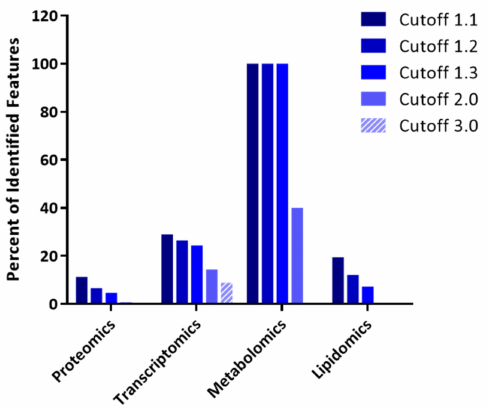
Figure 1. The impact of thresholding strategy on the integrative analysis of parallel multi-omics datasets. Bar graph representation of features remaining in each omics dataset after different levels of selection stringency for feature selection (fold-change cutoff value) used for input into the integrative analysis shown as percentages of the total identified features (see Table 1 for absolute numbers).